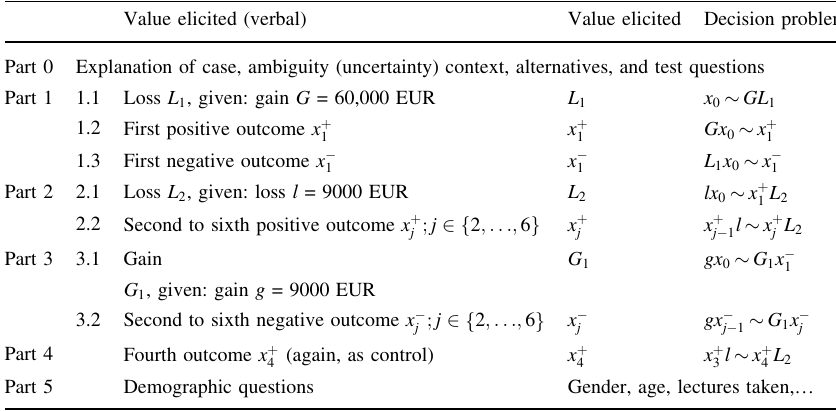
Table 2 Experimental stages and elicitation procedure following Abdellaoui et al. (2016); value elicited in monetary terms Value elicited